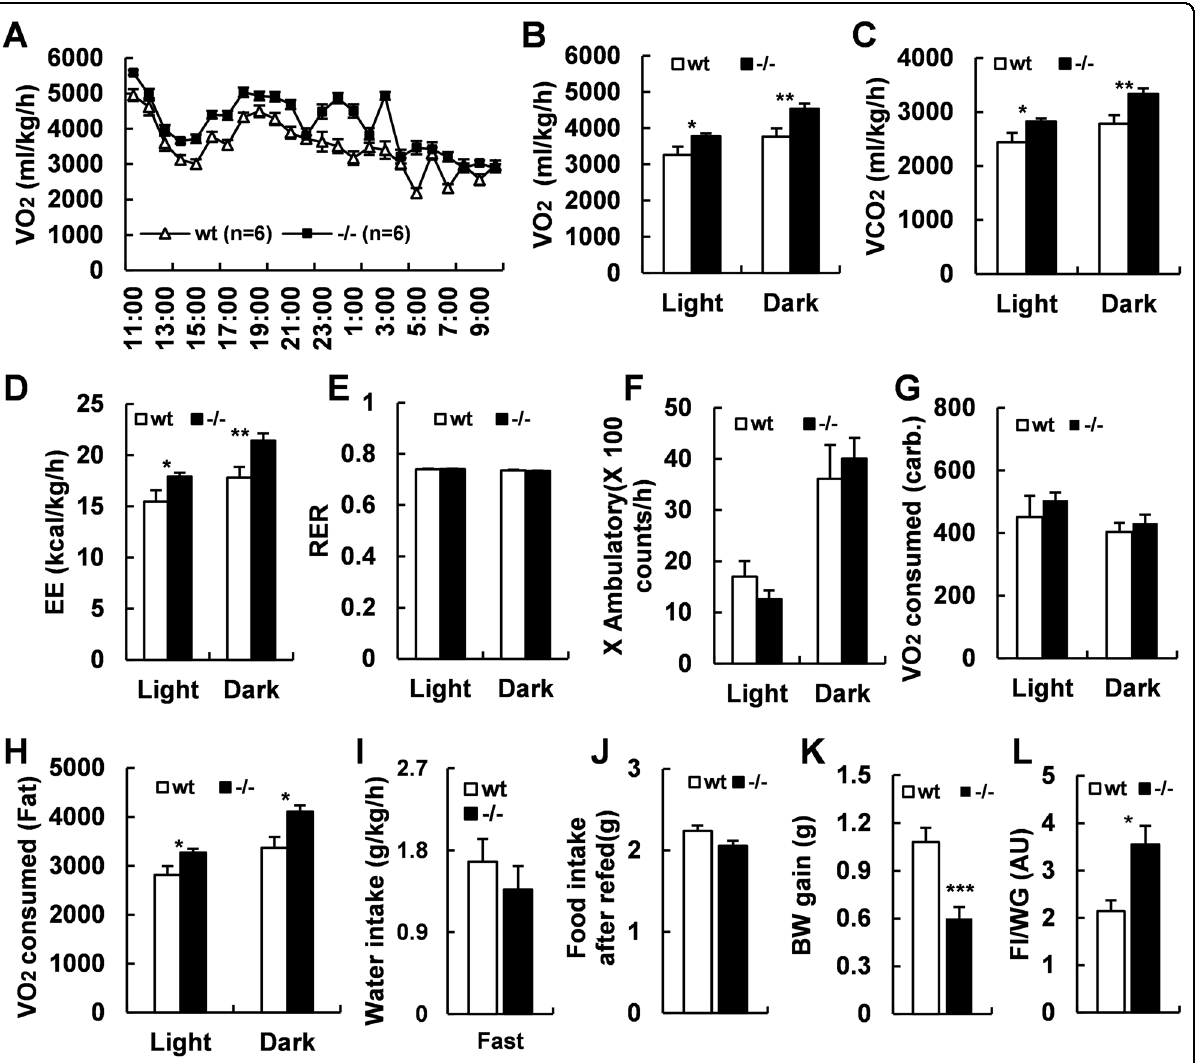
Fig. 3 Basal metabolic rate is increased in fasted Adgra1 − / − male mice. A – F At the age of 17 weeks, the metabolic cage studies assess O 2 consumption in curve diagram ( A ) and histogram ( B ), CO 2 production ( C ), energy expenditure ( D ), RER ( E ), and locomotor activities ( F ) during light and dark of fasted Adgra1 − / − male and control mice, n = 6/group. EE energy expenditure. G , H O 2 consumption for carbonhydrate ( G ) and fat ( H ) during light and dark, n = 6/group. I Water intake in fasted states, n = 6/group. J Food intake after refed for 24 h, n = 15/group. K Body weight gain after refed for 24 h, n = 15/group. L Ratio of food intake to body weight gain in fasted-refed male mice, n = 15/group. * p < 0.05, ** p < 0.01 vs. controls. Data represent mean ±